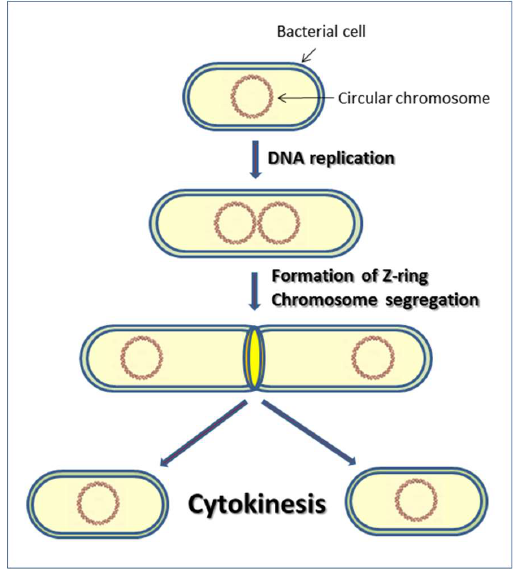
Figure 1. The cytokinesis process .